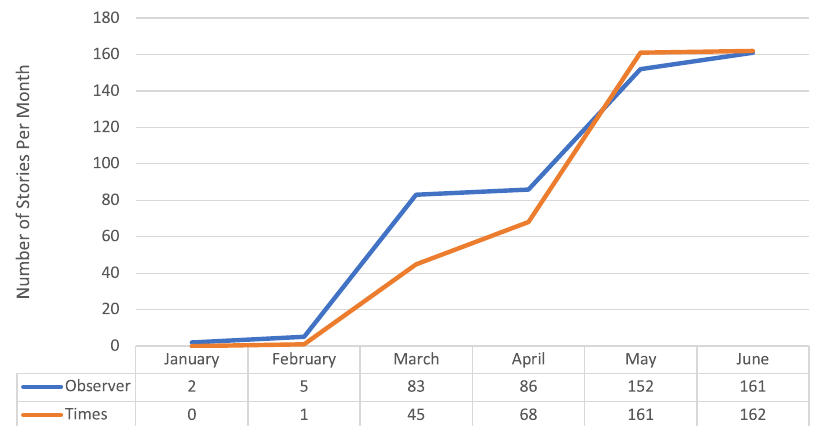
Fig. 1 Frequency and patterns of coverage. The chart shows the frequency and patterns of coverage between January and June 2020. Coverage was low in January but peaked as the virus was detected in South Africa and fi nally in